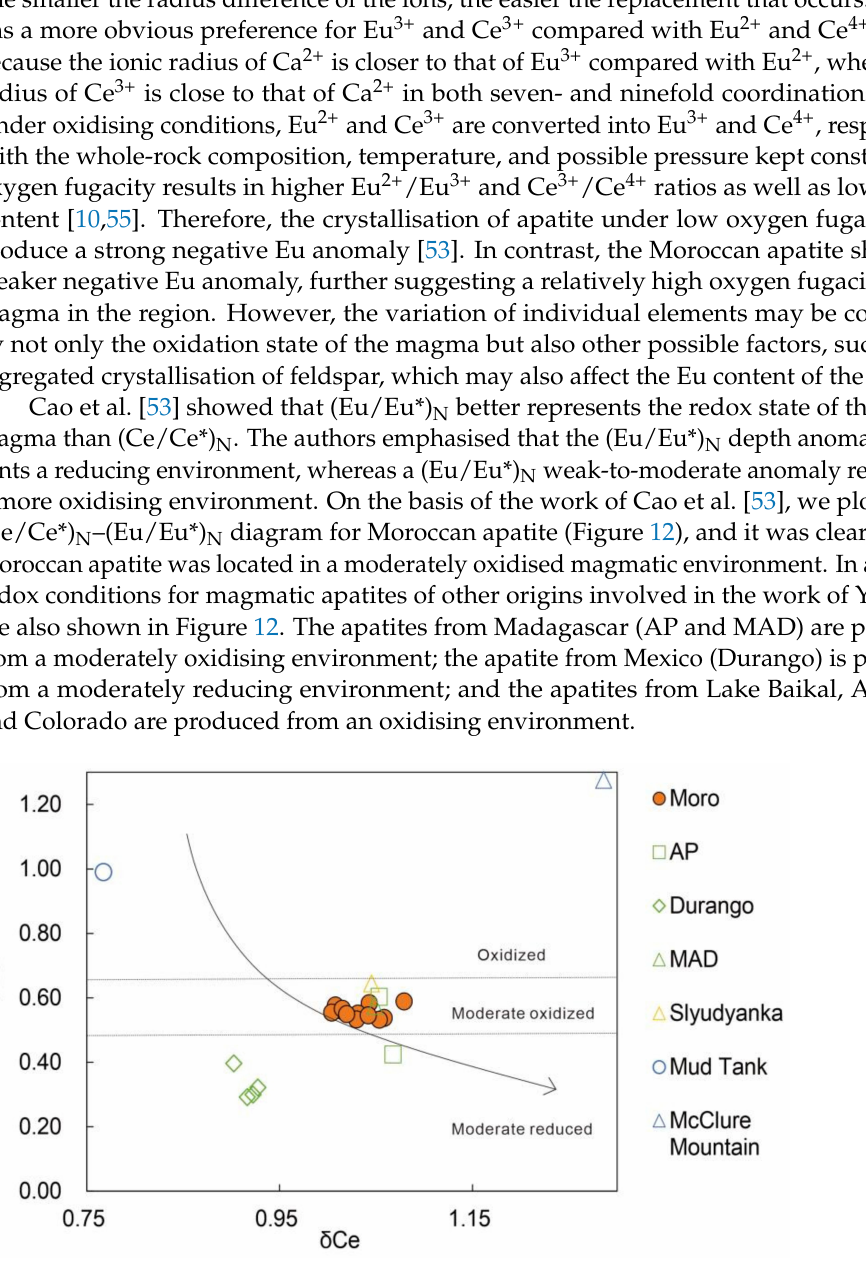
Figure 12. (Ce/Ce*) N –(Eu/Eu*) N diagram of the magmatic apatite, reflecting the degree of magma redox and oxygen escape [53] [ δ Ce = (Ce/Ce*) N and δ Eu = (Eu/Eu*) N ]. Modified from Cao et al.